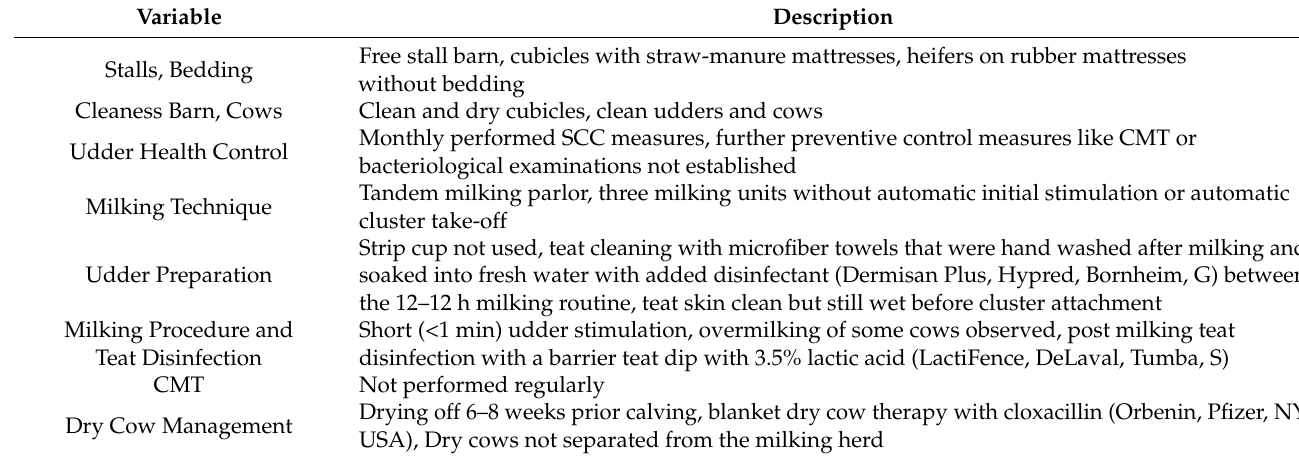
Table 2. Characteristics of the dairy farm.